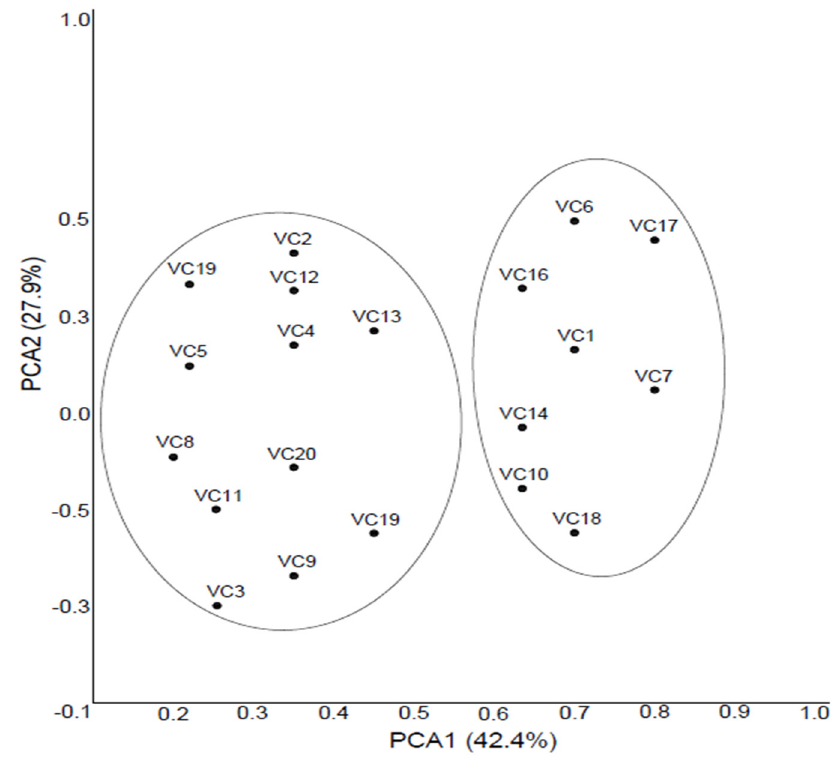
Figure 3. PCoA analysis of 20 black mulberry genotypes.